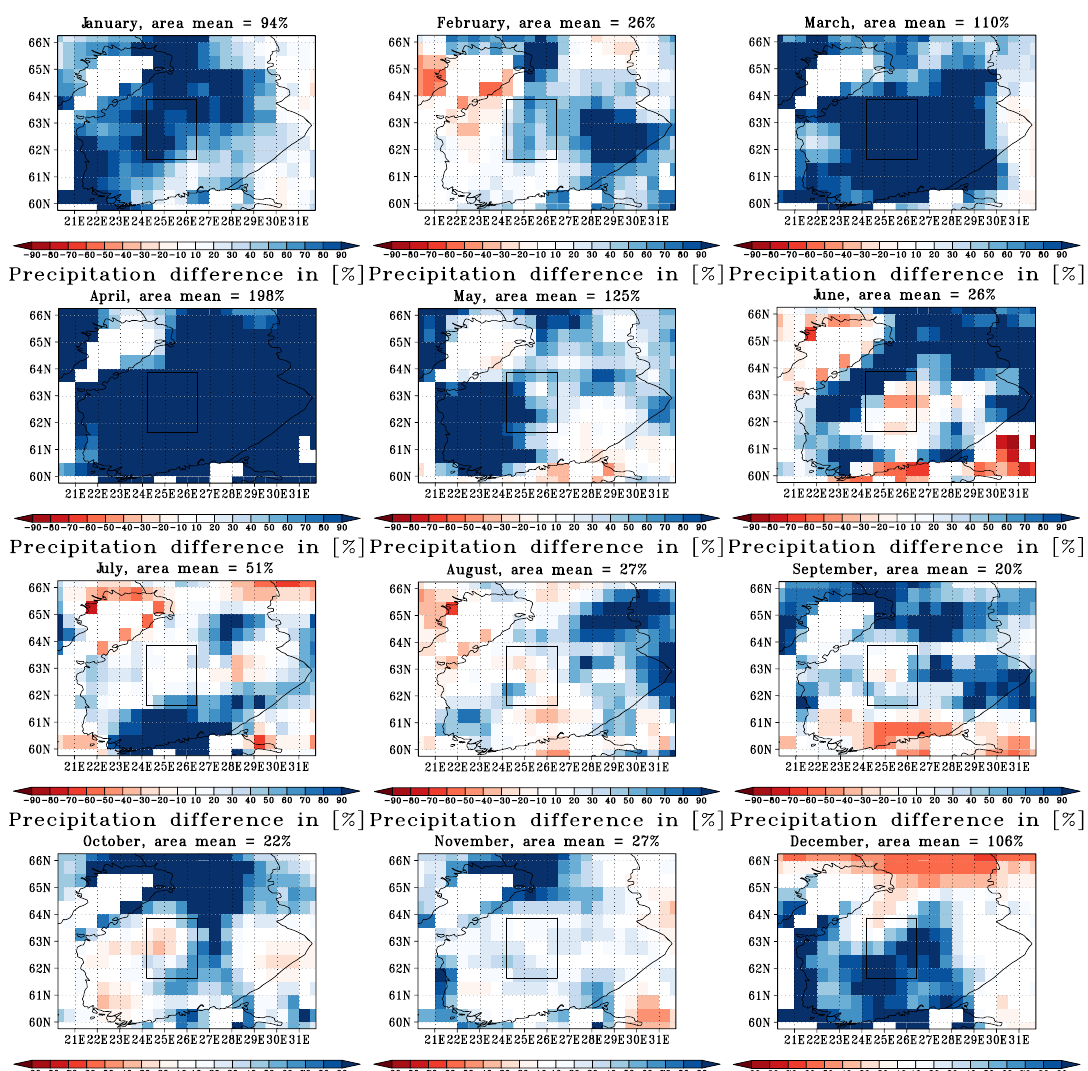
Fig. 17. Monthly percentage difference for precipitation in southern Finland. Blue and red colours represent the model overestimation and underestimation, respectively. White represents agreement. The central grid in the outlined square indicates Hyyti¨al¨a location, while the number above each panel represents the mean precipitation difference for the